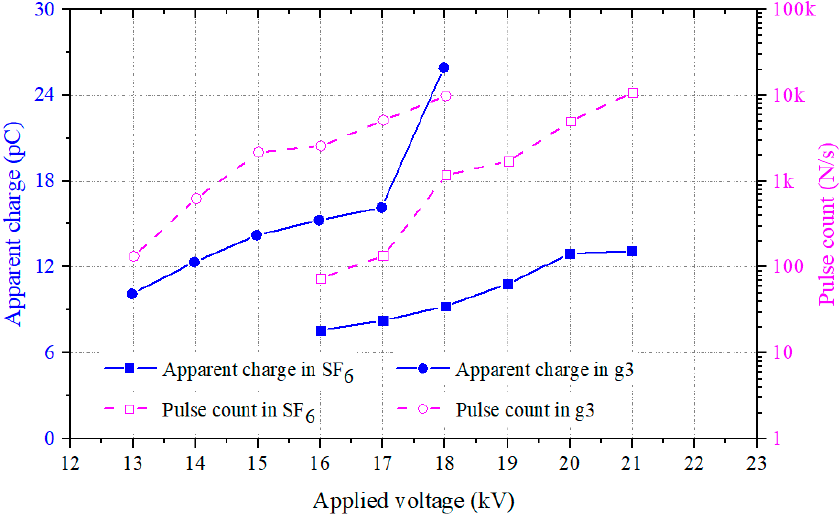
Figure A1. Average apparent charge and pulse count in SF 6 and g3 in the POE.